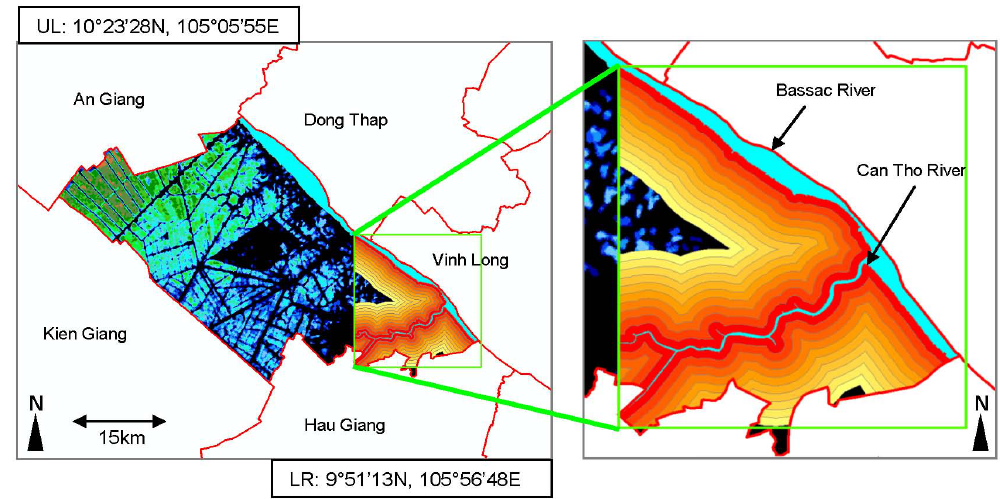
Figure 6. Buffer zones for the investigation of building density and flood patterns within the urbanized area of Can Tho City. Buffer zones are 500 m in width and reach up to 5 km inland (10